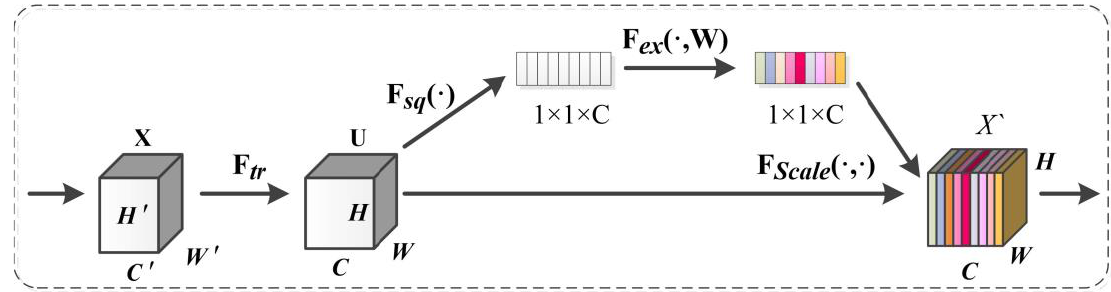
Figure 8. SE module structure diagram.